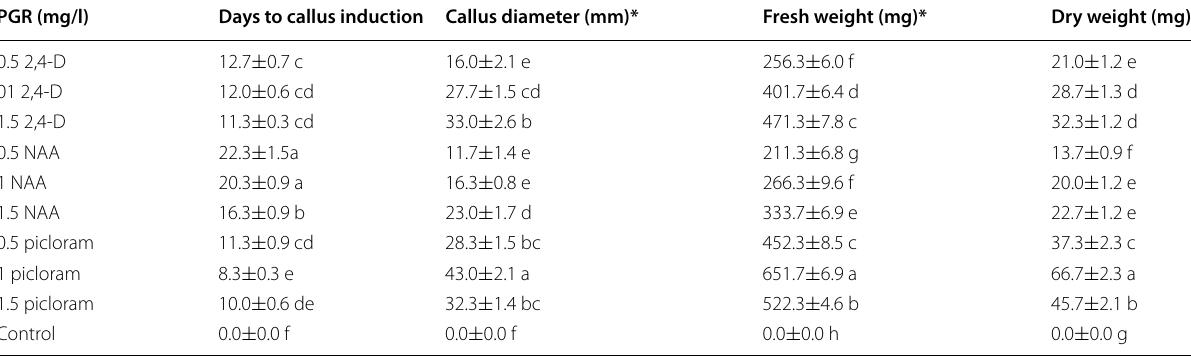
*Data recorded after 6 weeks of culture Data (mean standard error) represent three replicated treatments with 20 leaf explants per replication (control ± followed by the different letters are significantly different according to Tukey’s test at P